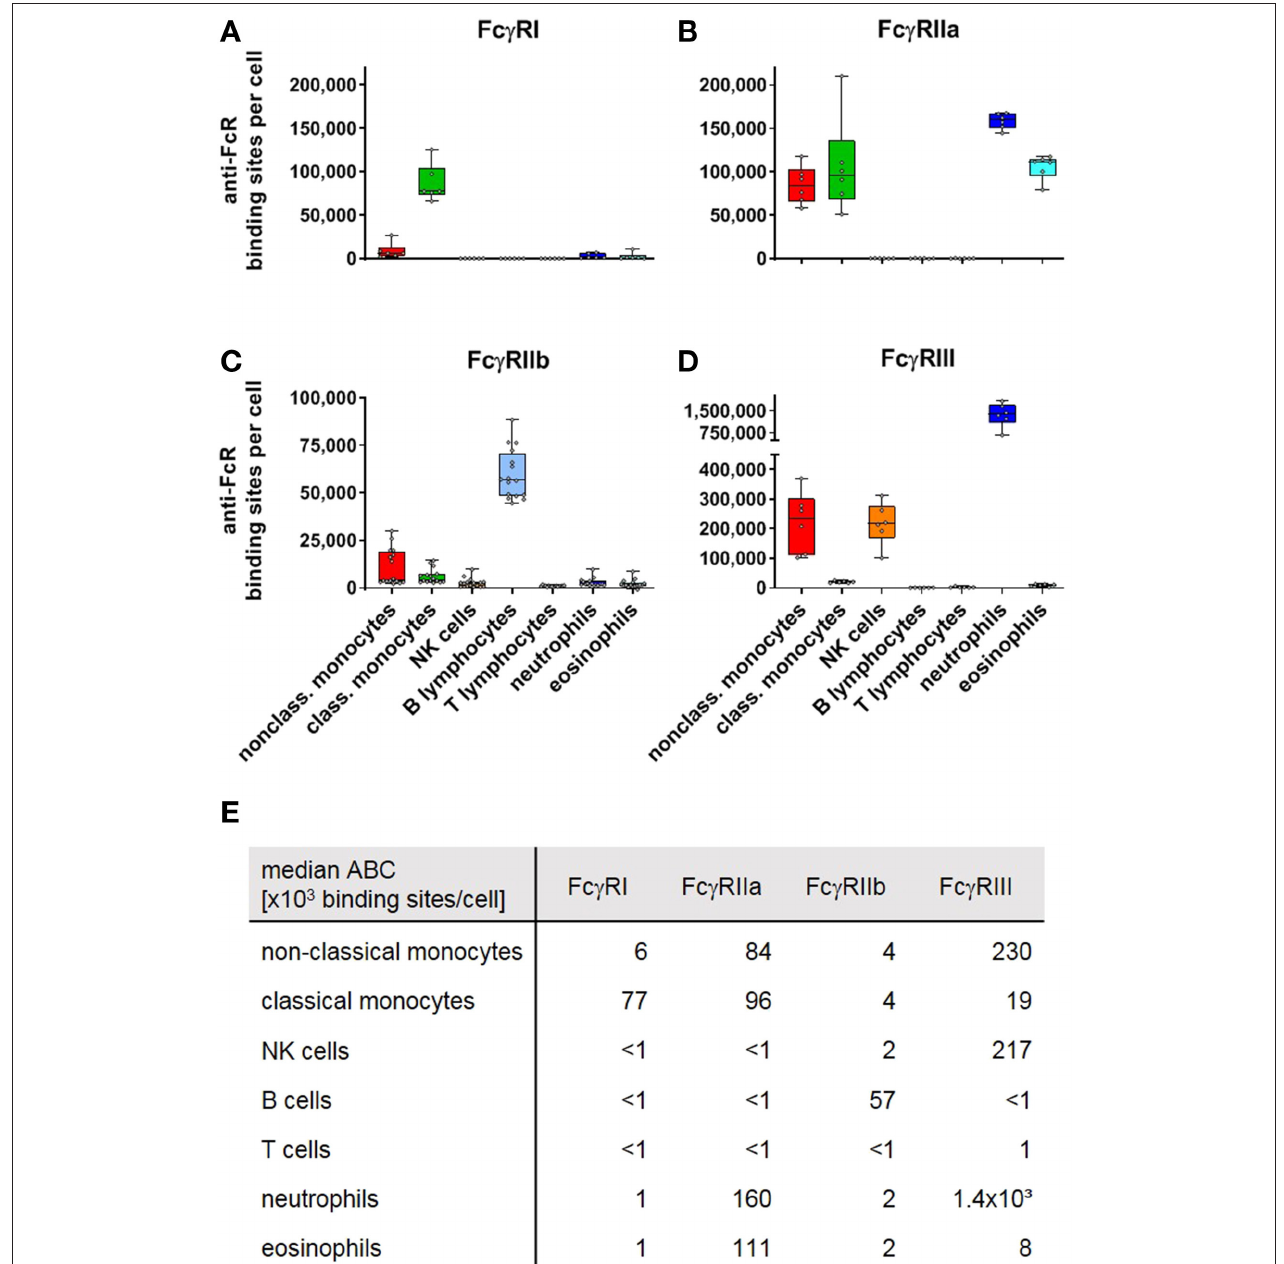
FIGURE 4 | Fc gamma receptors on human peripheral blood leukocytes. Depicted are box plots showing anti-FcR binding sites for (A) Fc γ RI, (B) Fc γ RIIa, (C) Fc γ RIIb, and (D) Fc γ RIIIa/b on indicated leukocyte subsets together with (E) a tabular presentation of the median number of binding sites. n = 6 (Fc γ RI, IIa, III) and 16 (Fc γ RIIb).